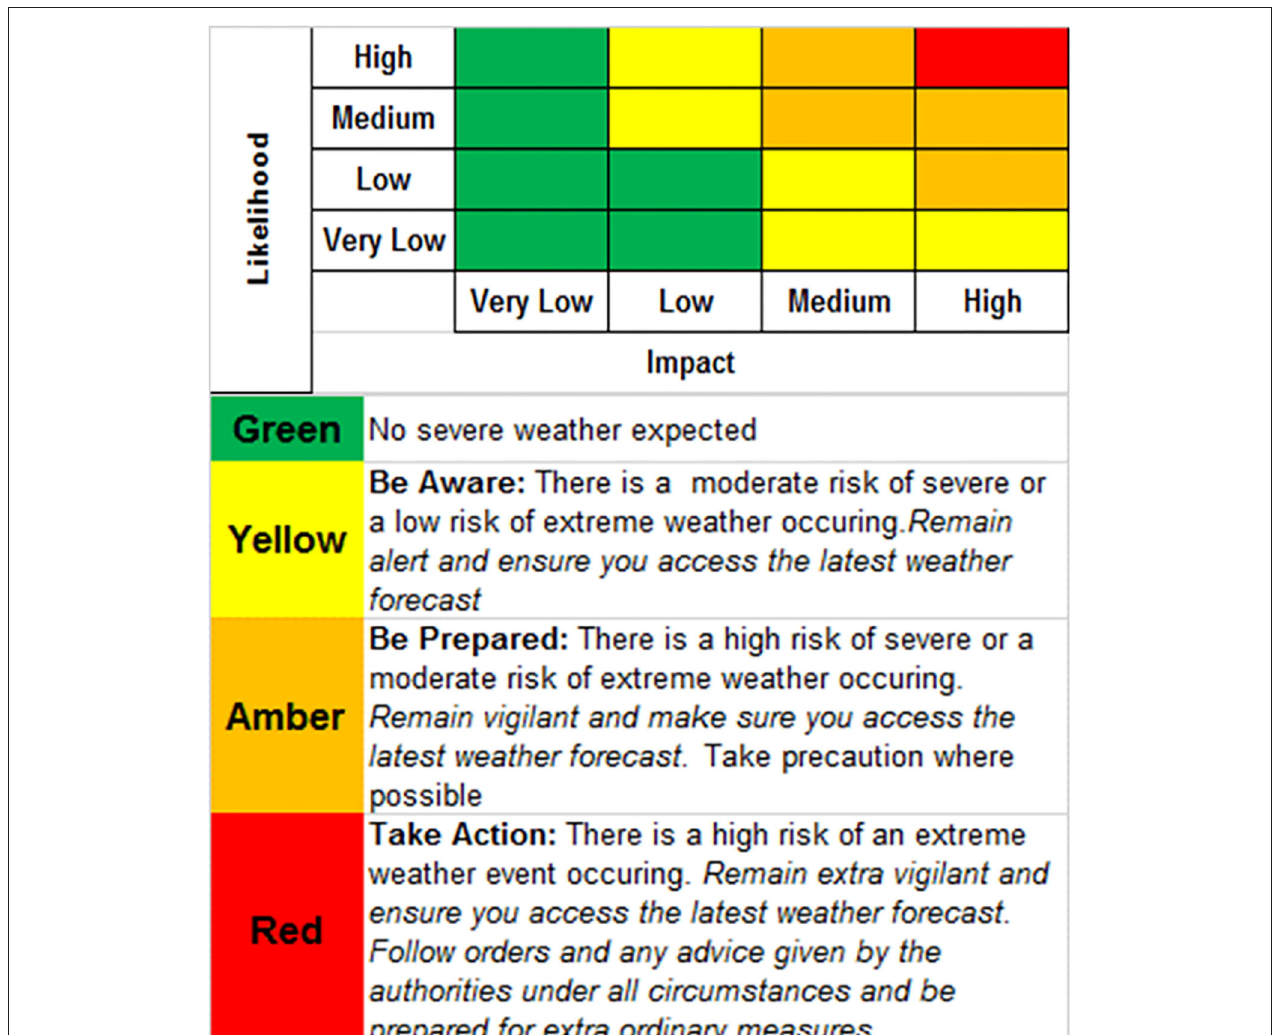
FIGURE 1 | Colour coded weather warning matrix (source: WMO,